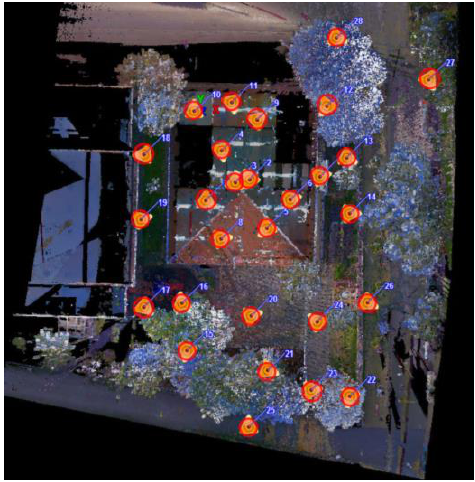
Fig. 2. Top view of area showing laser scanner set-ups